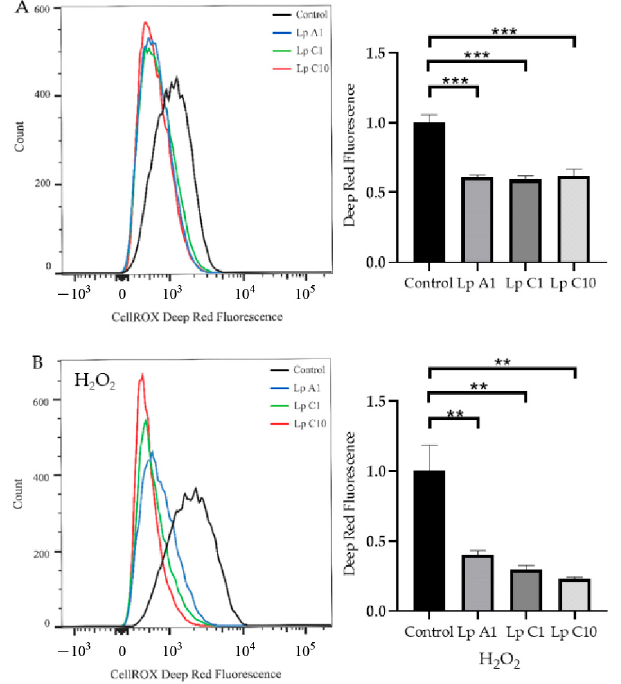
Figure 5. Reactive oxygen species (ROS) levels in bovine jejunum epithelial cells treated with Lactiplantibacillus plantarum A1, C1 and C10, under conditions without ( A ) or with ( B ) 200 μ mol/L H 2 O 2 . Values are means ± standard error; ** p < 0.01, *** p < 0.001. Lp = Lactiplantibacillus plantarum.